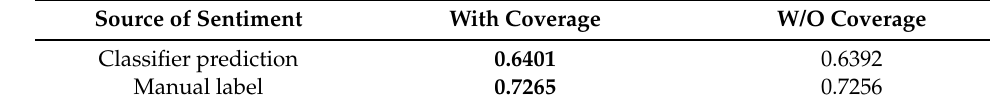
Table 10. Pipeline subsentence extraction results summary.